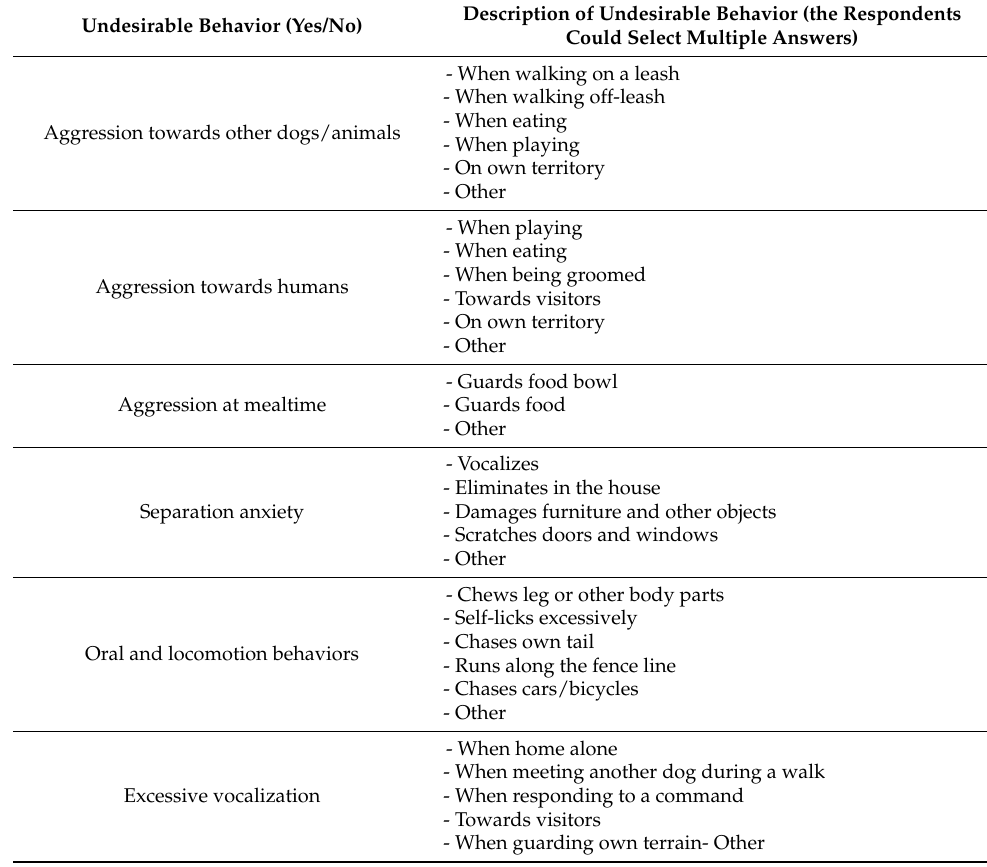
Table 1. Undesirable behaviors analyzed in the